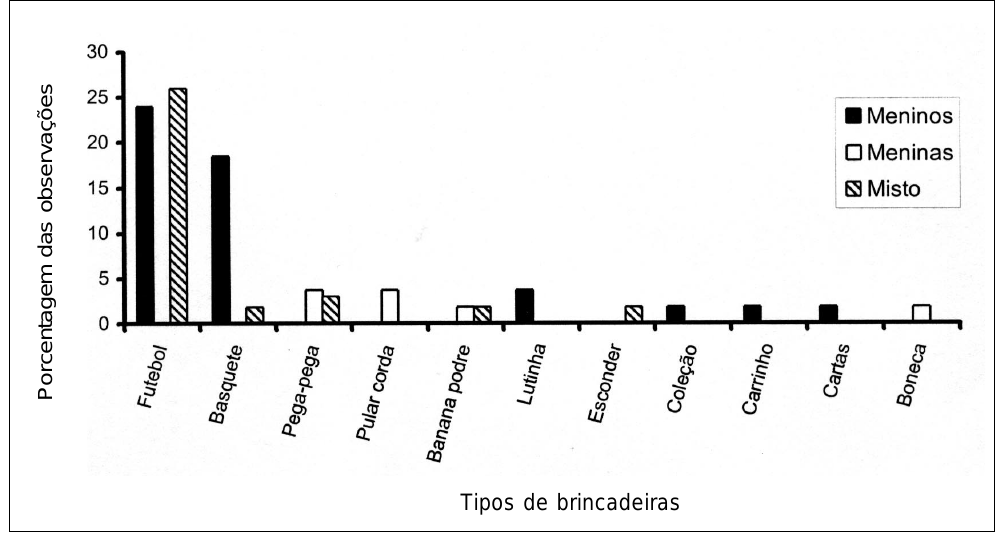
Tipos de Figura 4. Tipos de brincadeiras e suas respectivas porcentagens, quanto ao gênero, observadas entre as crianças das 3 as e 4 as séries